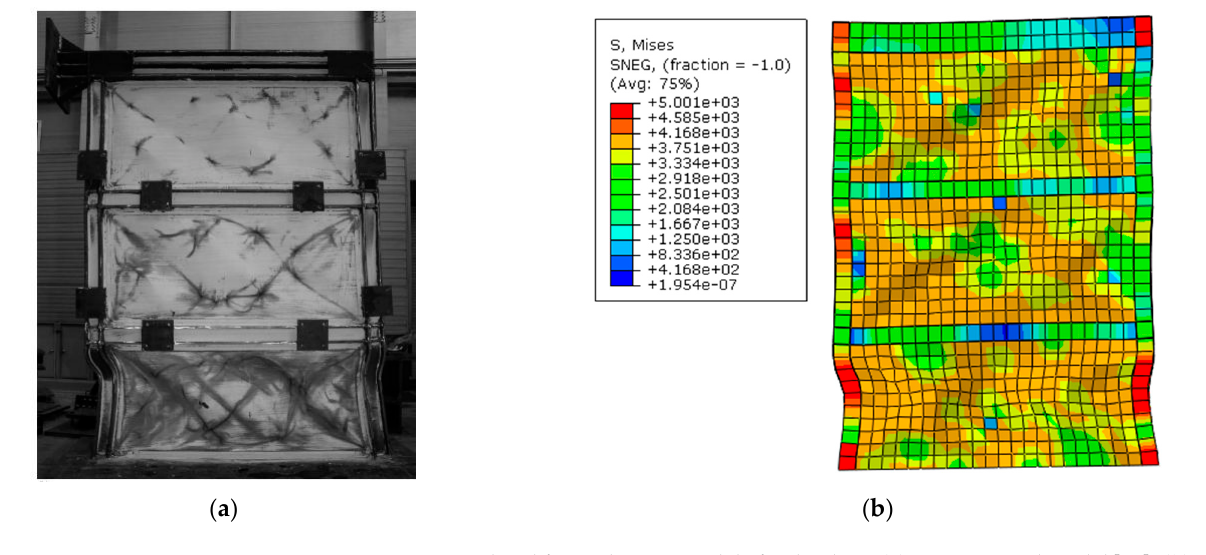
Figure 3. Experimental and finite element model after loading. ( a ) Experimental model [33]. ( b ) Finite element model.